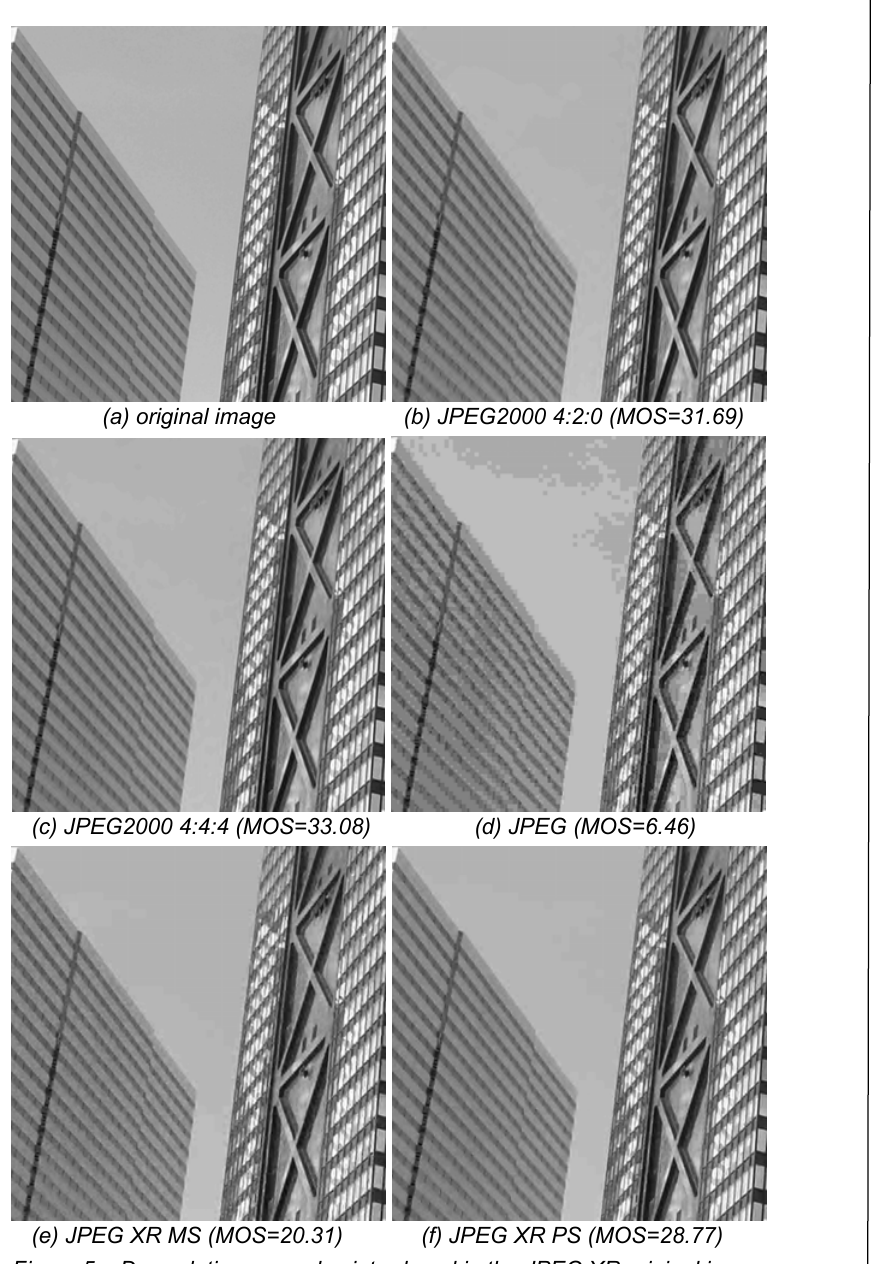
Figure 5 – Degradation examples introduced in the JPEG XR original image Рис . 5 – Примеры искажения исходного изображения из JPEG XR базы Слика 5 – Примери деградација унетих у изворну слику JPEG XR